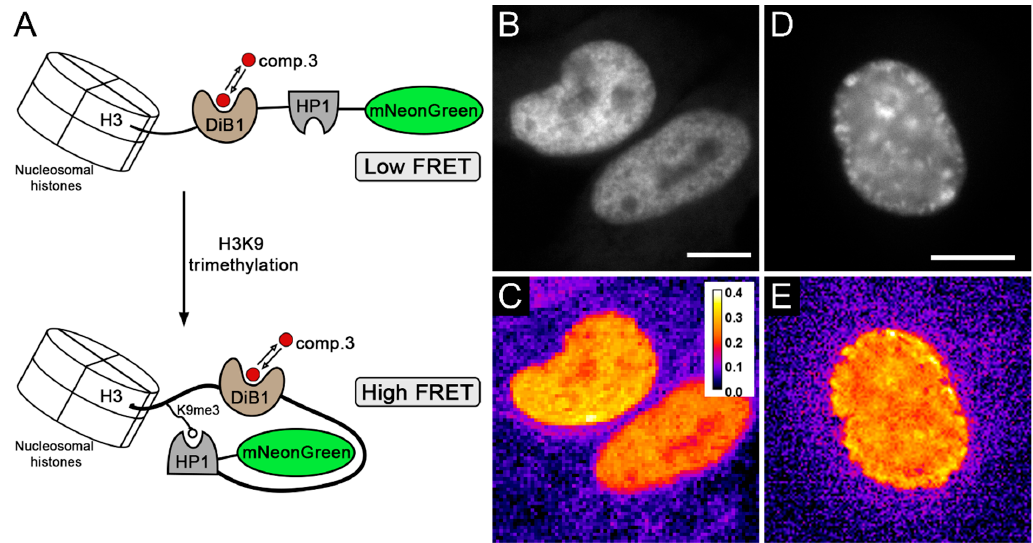
Figure 3. Modified biosensor for H3K9 trimethylation evaluation based on a new FRET pair